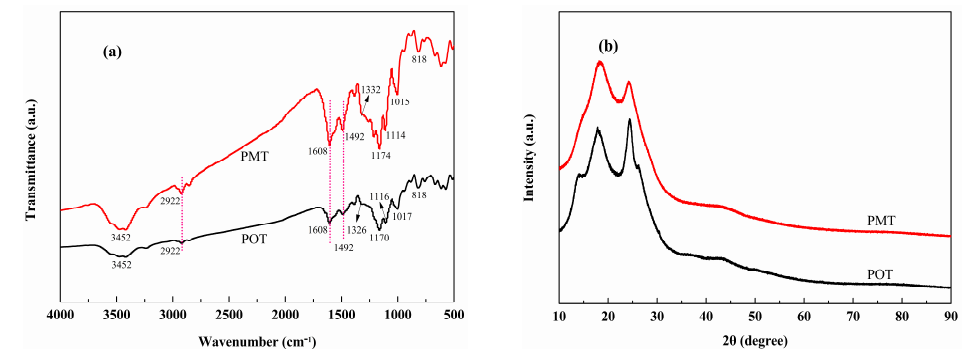
Figure 2. Structure analysis of poly(o-toluidine) (POT) and poly(m-toluidine) (PMT): ( a ) Fourier transformation infrared spectroscopy (FTIR) spectra and ( b ) X-ray diffraction (XRD) patterns. The survey X-ray photoelectron spectroscopy (XPS) spectra and the fitted N 1s peaks of poly(o/m-toluidine) are shown in Figure 3. As shown in Figure 3a, the wide range XPS spectra of POT The XRD patterns of poly(o/m-toluidine) are illustrated in Figure 2b. As shown in Figure